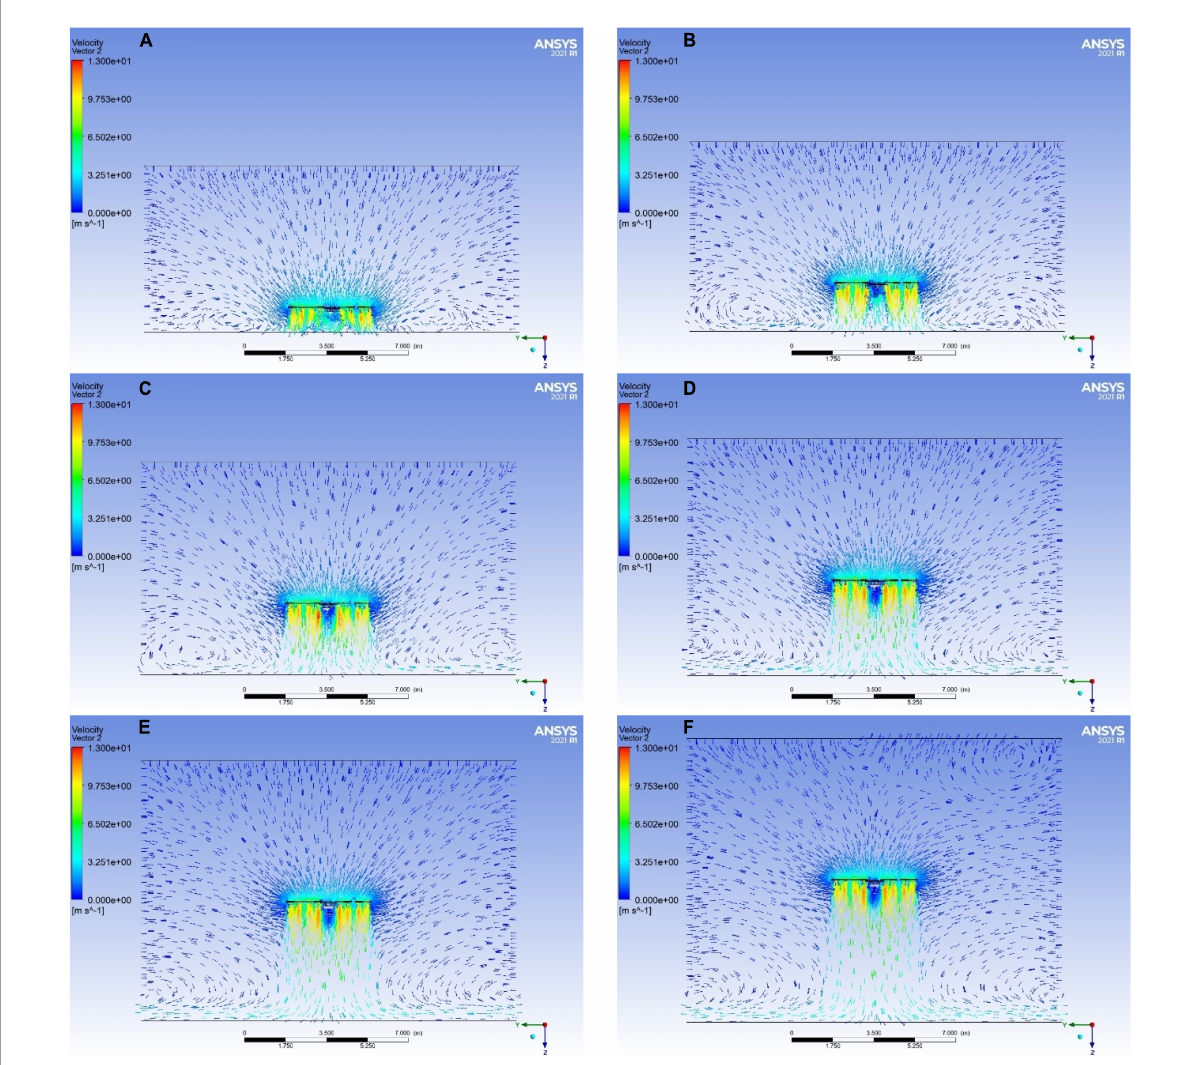
FIGURE8 Flow field velocity vector illustration of the mUAV flying at different altitudes. (A–F) Indicate that the mUAV is flying at 1, 2, 3, 4, 5, and 6 m above the ground, respectively.